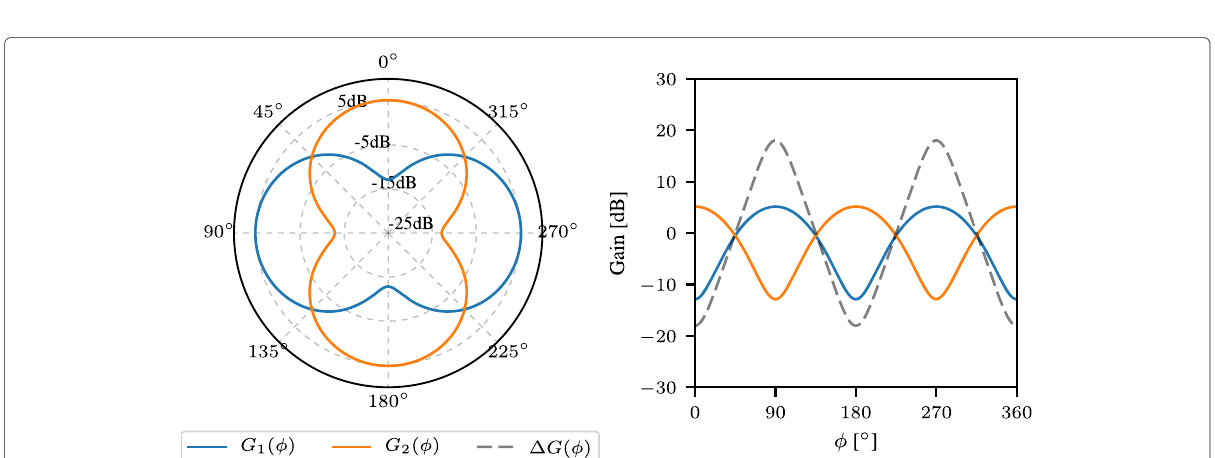
Fig. 2 The gain functions for both antenna configurations, rotated by 0° and 90°, are depicted in blue and orange, respectively. Also, the gain difference function (dashed gray) and its derivative (dotted green) are